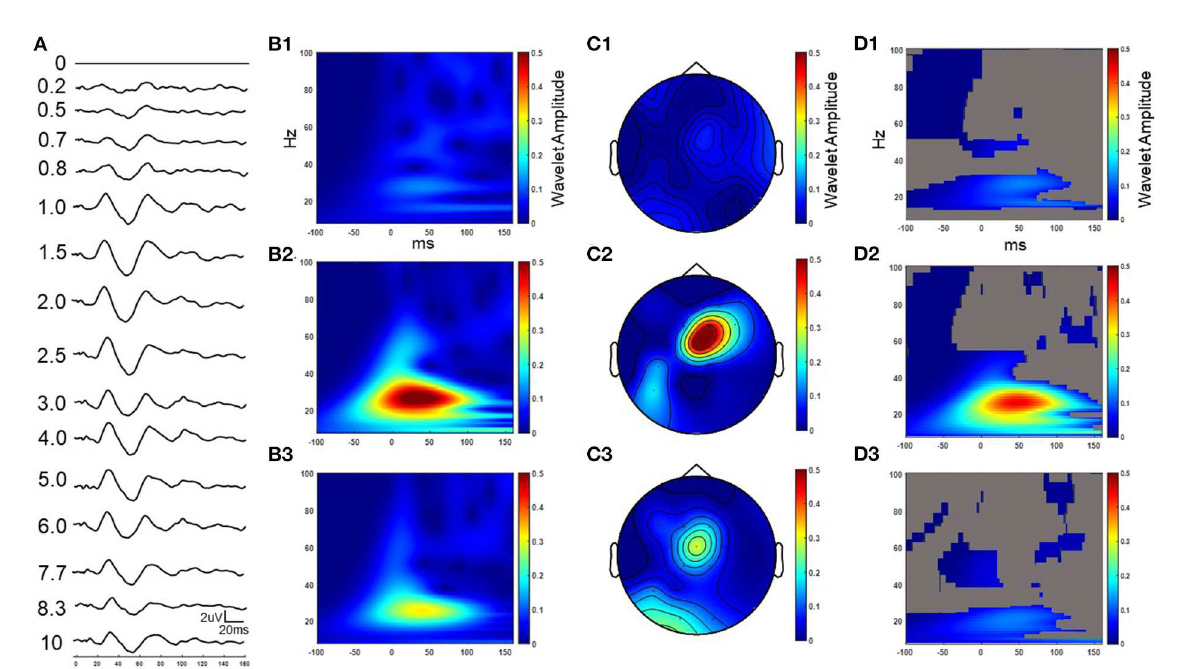
FIGURE4 Example cortical evoked response (FC2) to increasing IPIs from participant 3 while on medication. The result in the time domain post subtraction of the single pulse from the paired pulse at increasing IPIs (A) . The wavelet response of the time domain subtracted 0.2, 2.5, and 10 ms IPI conditions from column A ( B1–B3 respectively). Wavelet spatial localization of the 0.2, 2.5, and 10ms IPI conditions from column A ( C1–C3 respectively). Permutation statistics comparing wavelet amplitude differences in the frequency domain between the single pulse and non-subtracted paired pulses at the 0.2, 2.5, and 10 ms IPIs with non-significant time-frequency zones shown in gray ( D1–D3 respectively). Z scales are wavelet amplitudes and time zero is aligned to the stimulation artifact with plots showing frequencies between 8-100